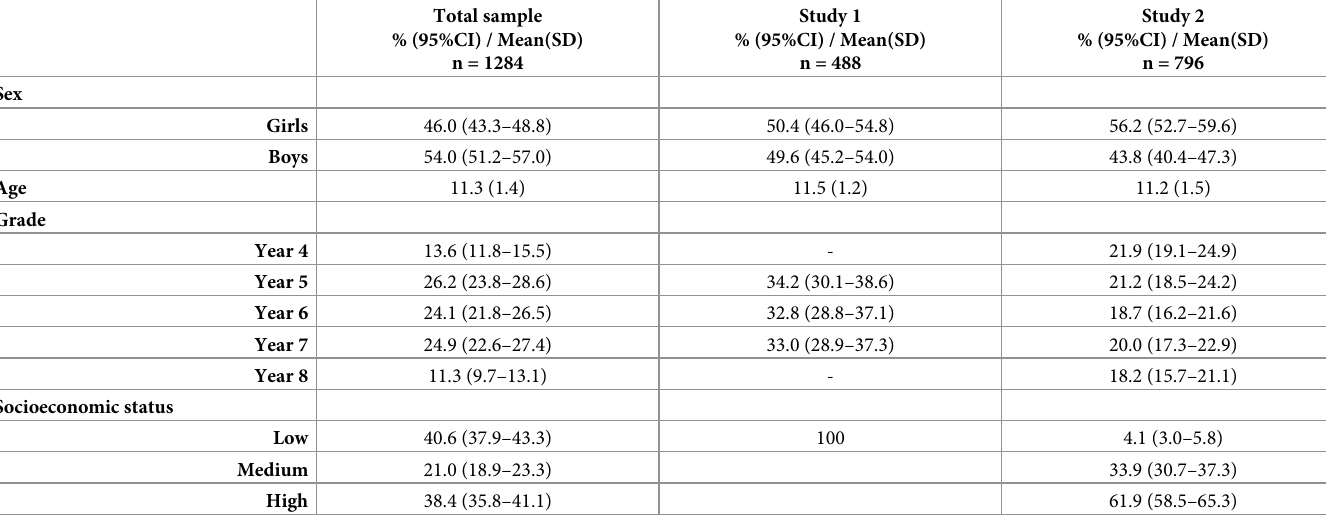
Table 1. Descriptive features of parent-child dyads with complete data.